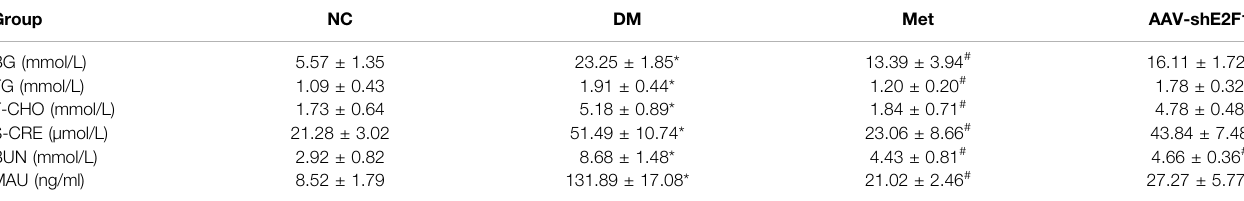
TABLE 1 | Changes in BG, TG, T-CHO, S-CRE, BUN, and urine microalbumin of mice in each group (n = 6,* p < 0.05 vs. NC. # p < 0.05 vs. DM).